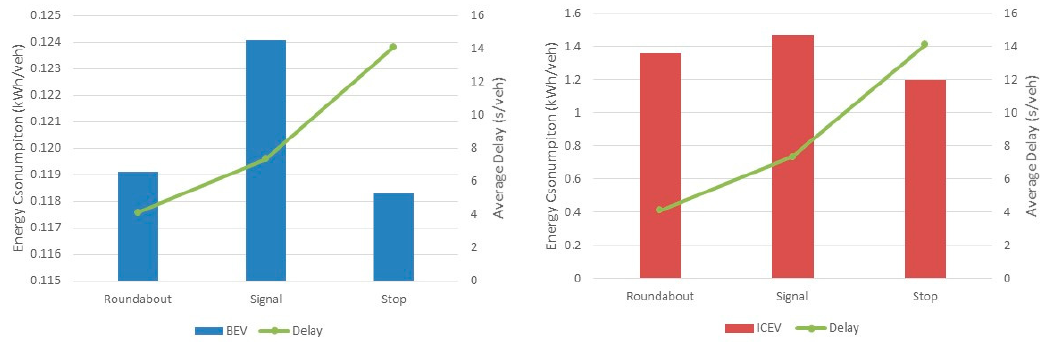
Figure 4. Comparison of BEV and ICEV energy/fuel consumption for different intersection control strategies (approach speed = 56 km/h).